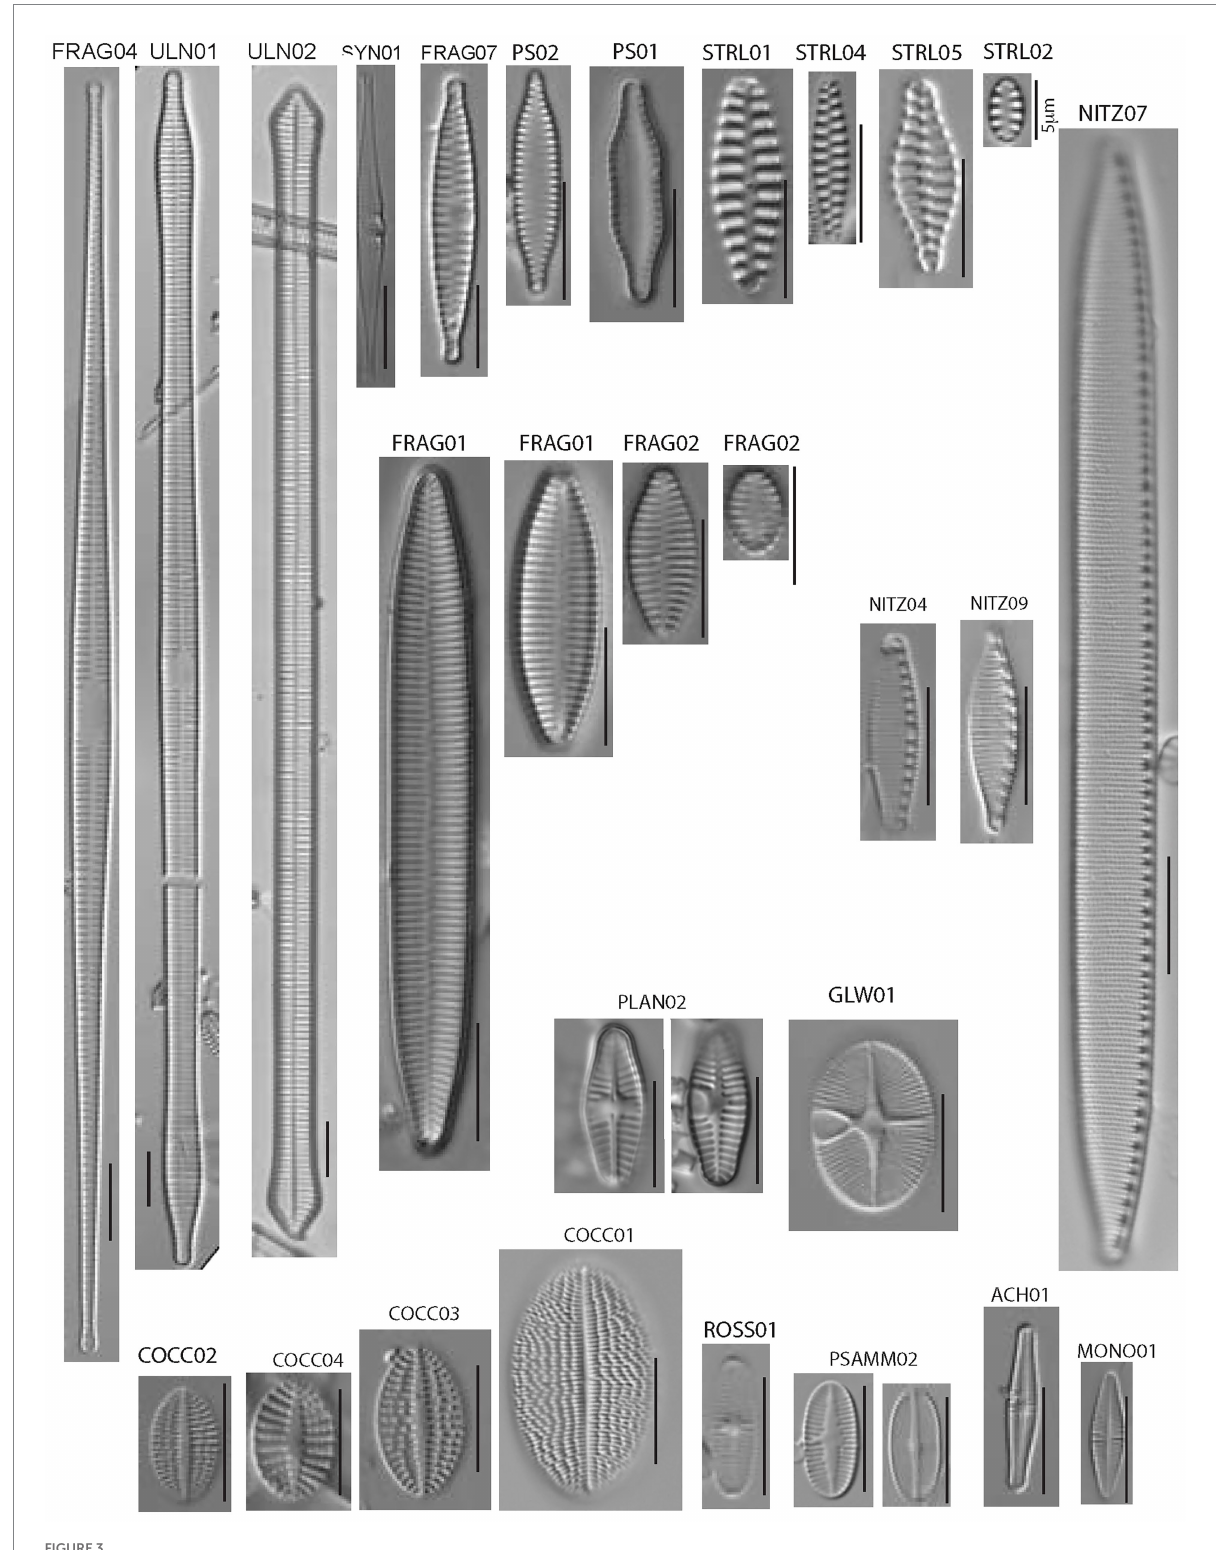
FIGURE 3 Transmitted light photomicrographs of common araphid, nitzschioid, and monoraphid diatoms identified in this study. All scale bars are 10 microns in length unless otherwise